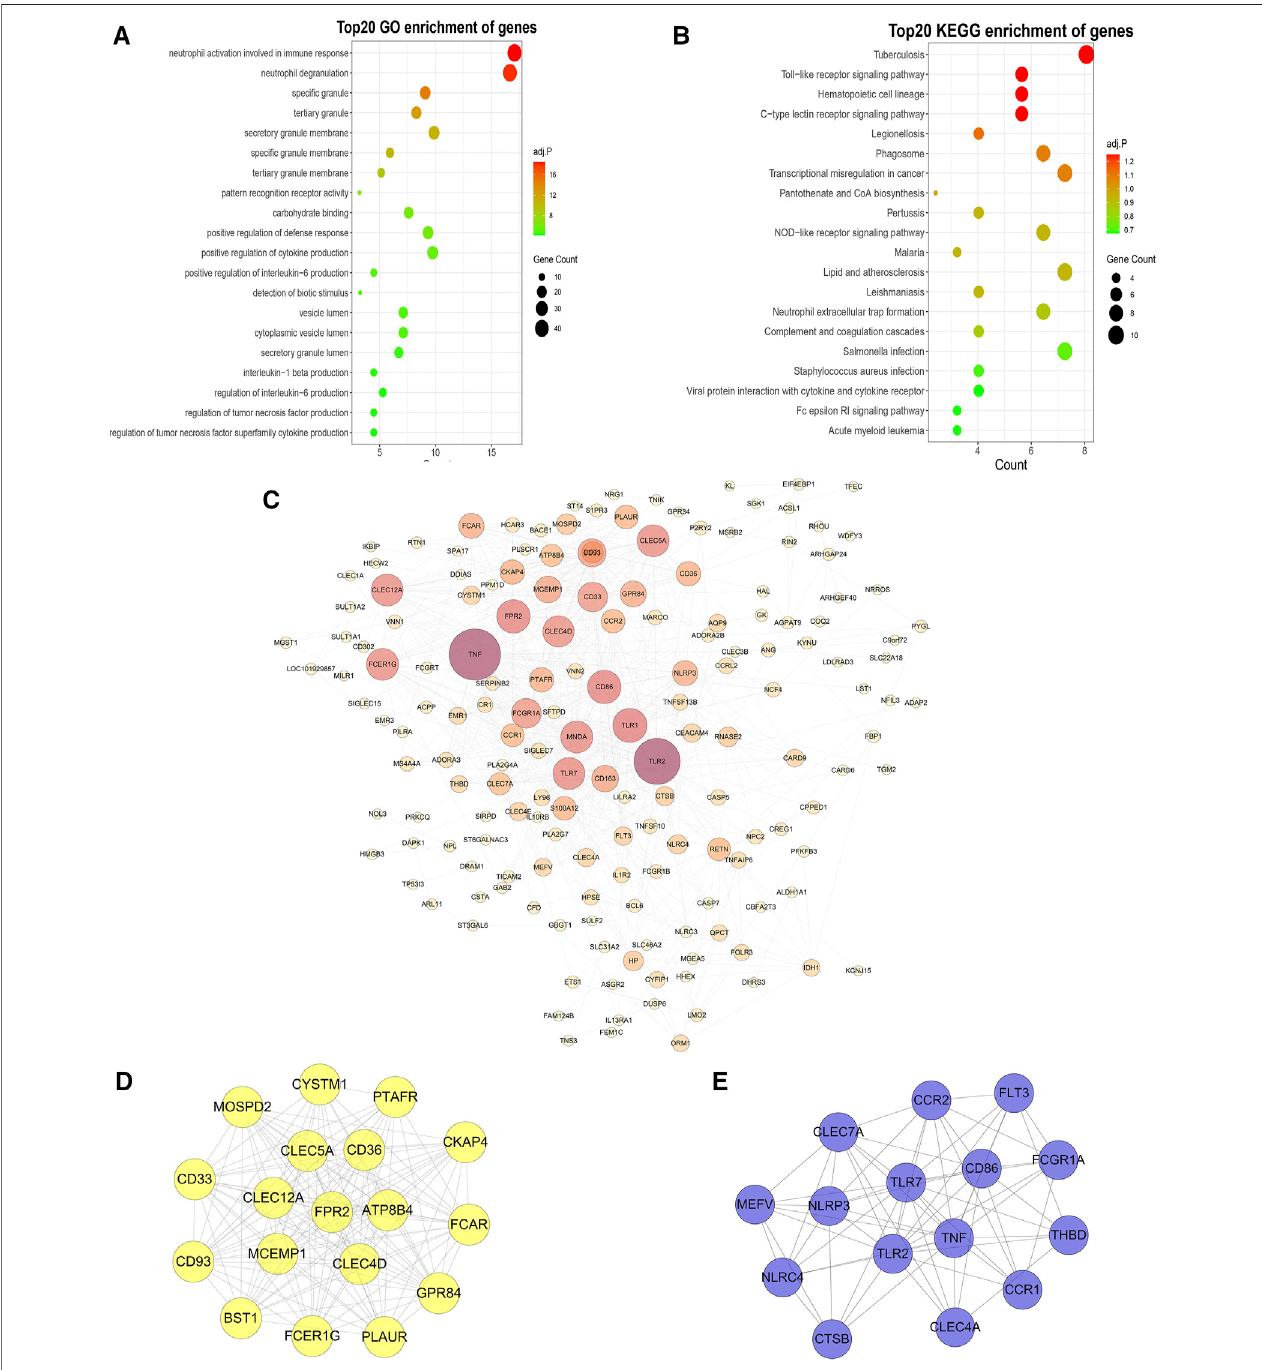
FIGURE 4 | GO and KEGG enrichment analysis, PPI networks and hub genes. (A,B) : GO (A) and KEGG (B) enrichment analysis of yellow module genes. (C) : PPI network analysis of yellow module genes. The edge represents the interaction between two proteins. A greater node indicates that the protein is more important in the network. (D,E) : The two most closely connected network clusters in the PPI network identi fi ed using the MCODE plugin. [ (D) : cluster 1: score = 16.353, node = 18, edges = 139; (E) : cluster 2: score = 9.429, node = 15, edges = 66].